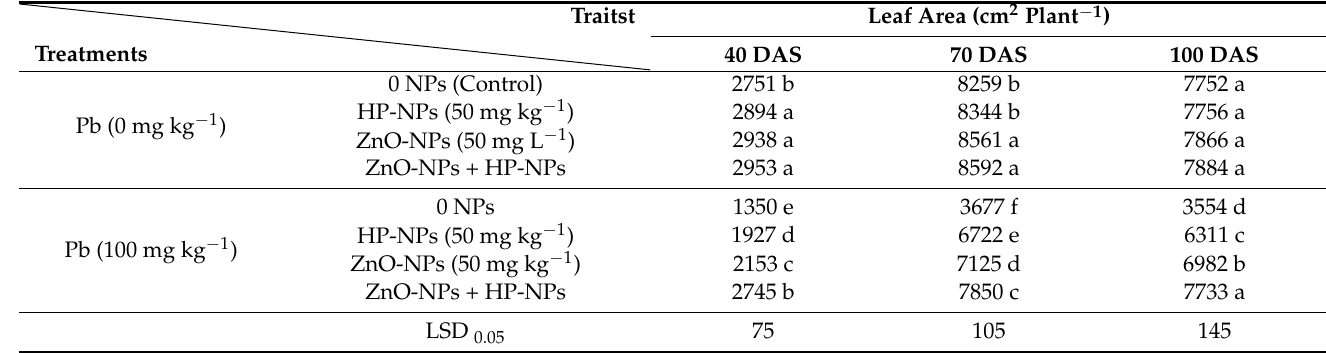
Table 1. Effects of nano-hydroxyapatite NPs (NH NPs), zinc oxide NPs (ZnO-NPs), and their combinations on leaf area (cm 2 plant − 1 ) of maize grown in soil contaminated with Pb.